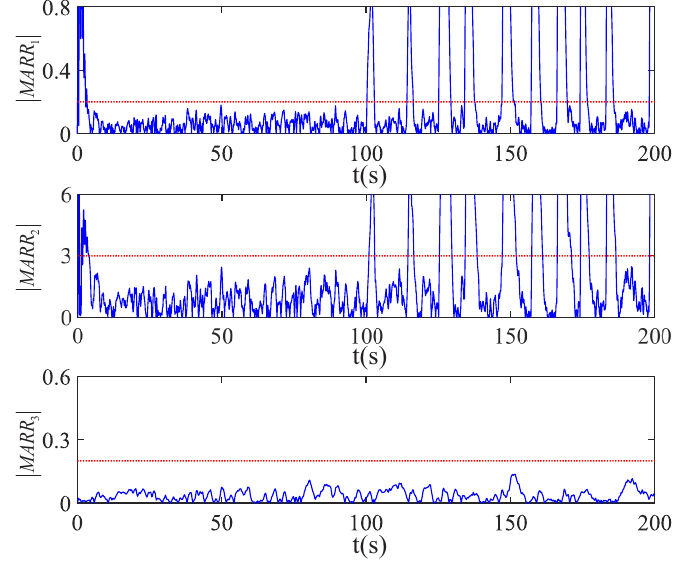
Figure 9. Residual responses under β θ